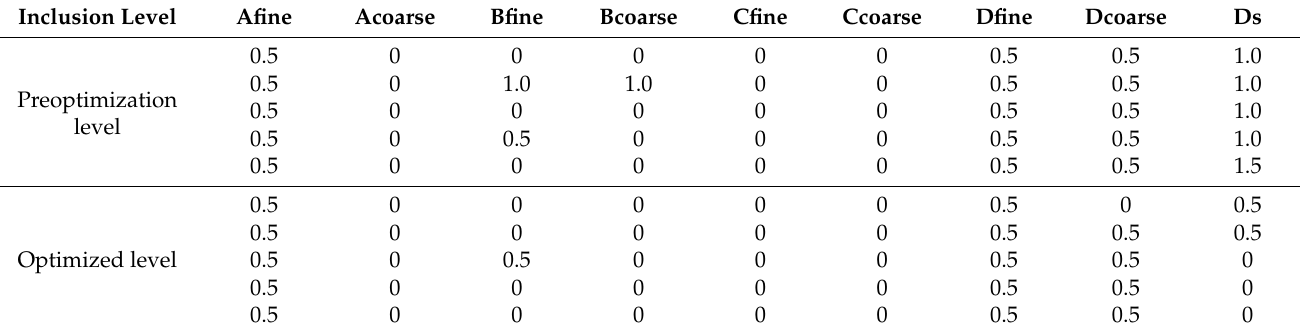
Table 9. Comparison of inclusion rating results before and after